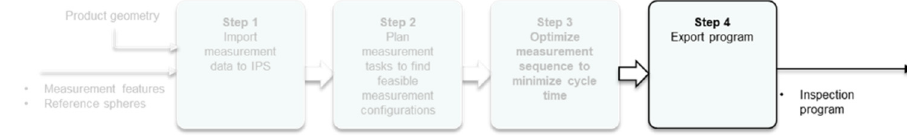
Figure 35. The evolved IPS LR system concept, Step 4.